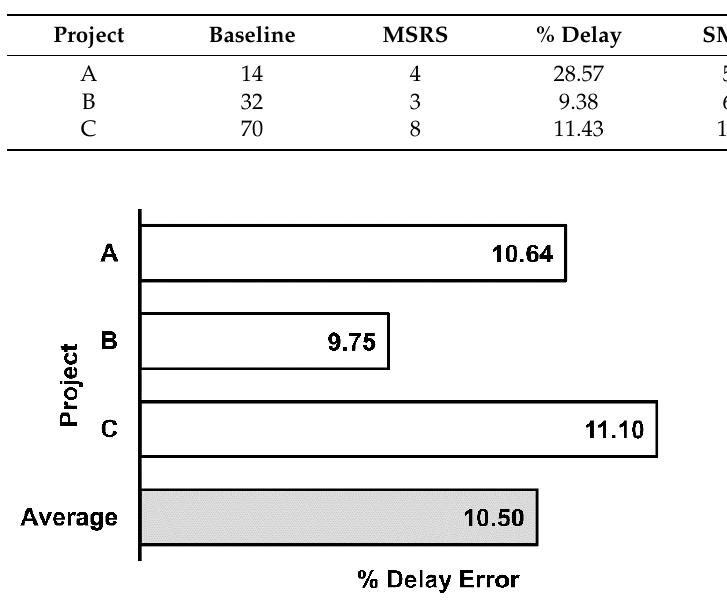
Table 10. Percentage delay.